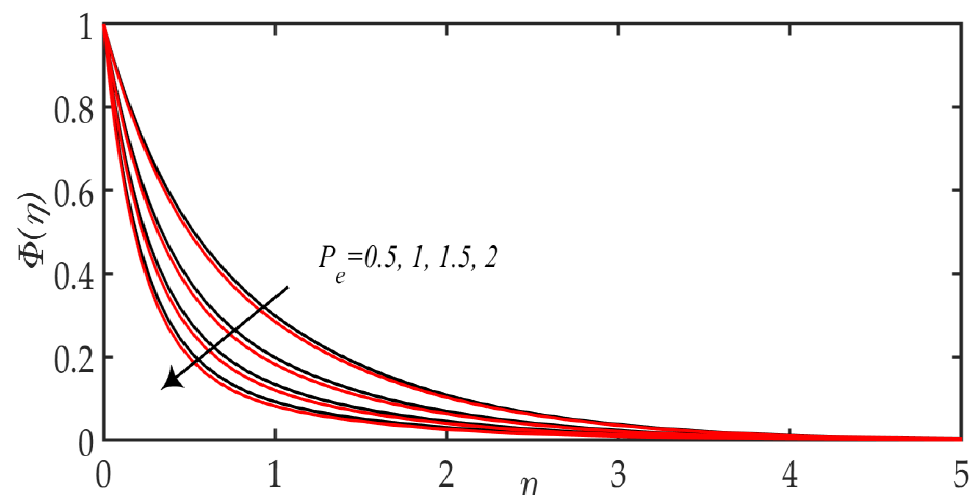
Figure 11. Variation of 𝑃 𝑒 and Ω 𝑑 on microorganism profile. Solid line: Ω 𝑑 = 0.1 , Dotted line: Figure 11. Variation of P e and Ω d on microorganism profile. Solid line: Ω d = 0.1, Dotted line: Ω = Ω = 0.3 . d 𝑑 Table 1. Numerical convergent values of Nusselt number, Sherwood Number, and the local density number of the motile microorganisms across 𝑁 , 𝑁 𝑡 , and 𝑁 𝑏 by fixing 𝑀 = 1, 𝛽 𝐷 = 𝐸 𝑐 = 0, 𝑁 𝑟 =